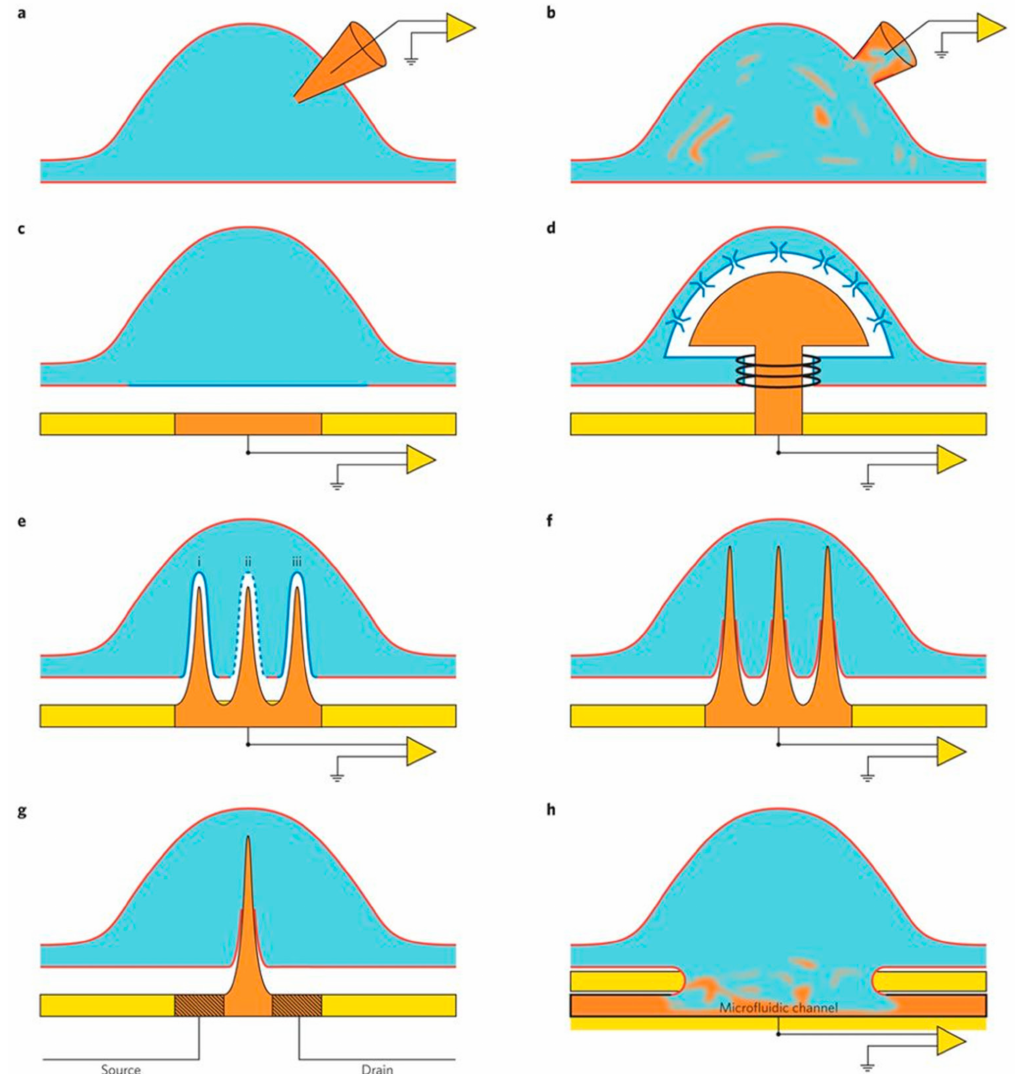
Figure 7. Different forms of the electrode/neuron and cardiomyocytes interface configuration. ( a ) A sharp glass intracellular microelectrode. ( b ) Whole-cell patch-electrode configuration. The ‘mixing’ of orange and blue schematically illustrates the perfusion of the cytosol by the electrode content. ( c ) A neuron cultured on a substrate-integrated planar extracellular electrode. Note the cleft (white) separating the junctional membrane and the electrode. ( d ) A neuron engulfing a gold mushroom-shaped protruding microelectrode. Note actin rings surrounding the mushrooms stalk, stabilizing the configu- ration. ( e ) Nanopillar electrodes extending into a cultured cardiomyocyte but do not penetrate the plasma membrane ( i ). After the application of an electroporating pulse, ( ii ) the nanopillar gains access to the cytoplasm. The electroporation is transient, and the junctional membrane resistance recovers to control level within minutes ( iii ). ( f ) An array of nanopillars that penetrate the plasma membrane forming direct physical contact with the cytosol. ( g ) A nanopillar that serves as the gate for a nanoFET penetrates the cell’s membrane. ( h ) Patch clamping of cultured neurons. The mixing of the ionic solution of the microfluidic system with the cytosol is depicted. For more details, see reference. Adapted with permission from Ref.